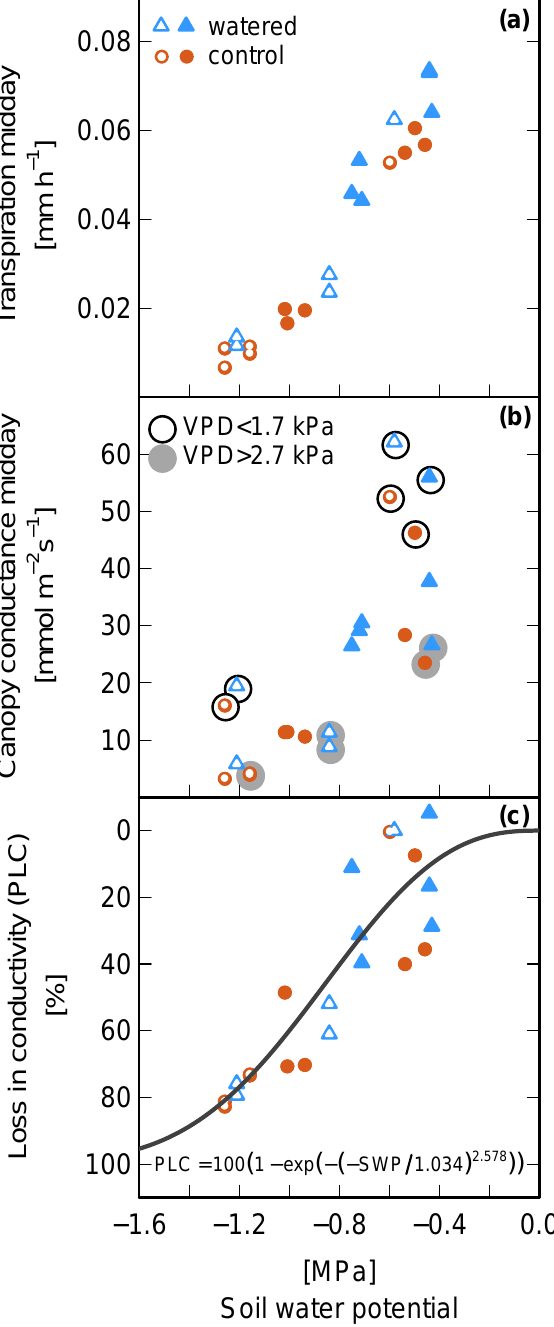
Figure 3. Changes in tree-water relations with declining soil Fig. 3. Changes in tree water relations with declining soil water potential (SWP; i.e., pre-dawn leaf water potential) for control and watered trees during summer 2011. Shown are changes in (a) midday tree transpiration, (b) midday stomatal conductance (Gs) affected by changes in VPD and (c) percent loss in tree conductivity (PLC). Open symbols indicate measurements taken outside the irrigation period in June and September. The relationship of PLC with SWP is represented by a Weibull function that has been integrated in the modified SPA model.